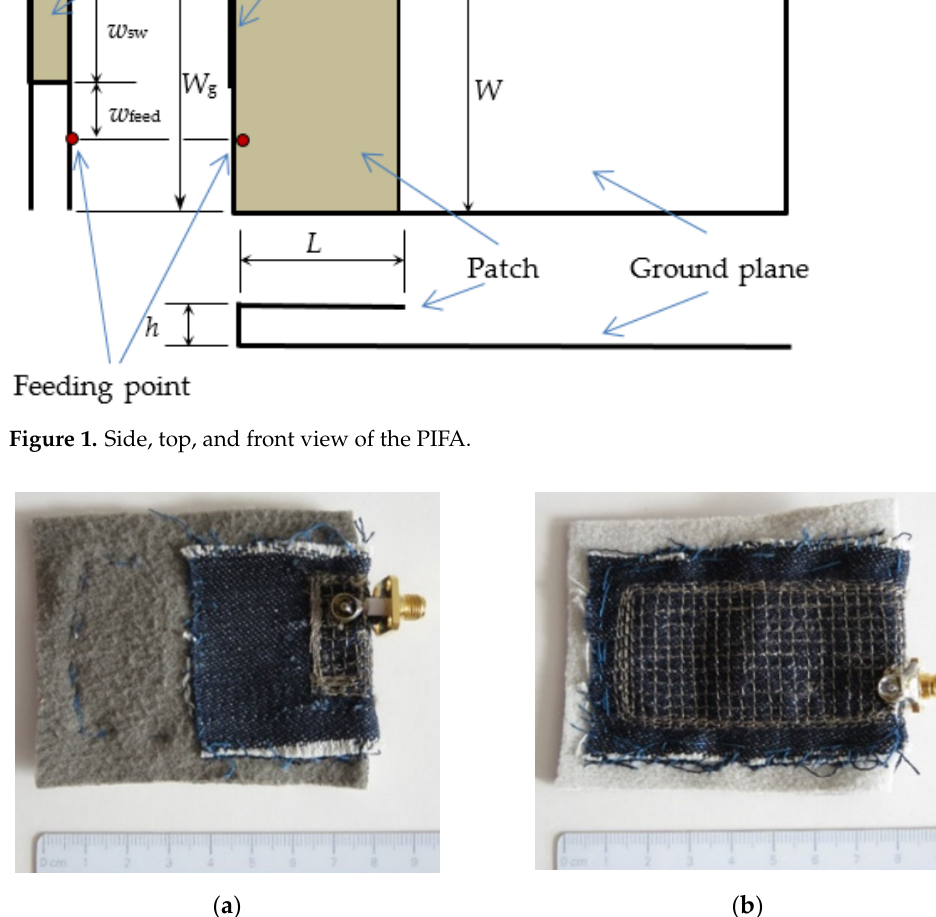
Figure 2. Textile PIFA prototype: ( a ) patch and ( b ) ground plane.